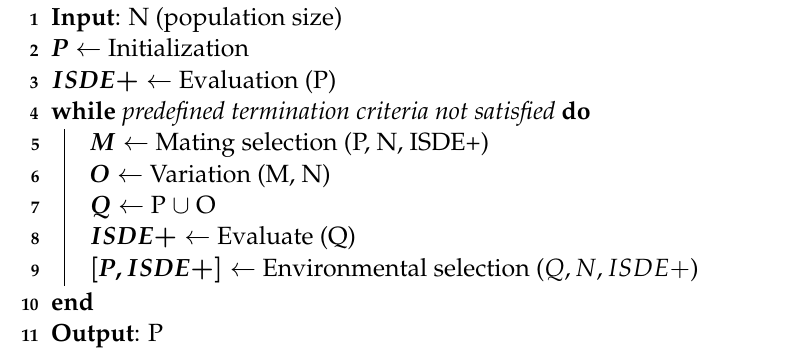
Algorithm 1: General framework of the CMOEA employed to solve the ED formulated as a